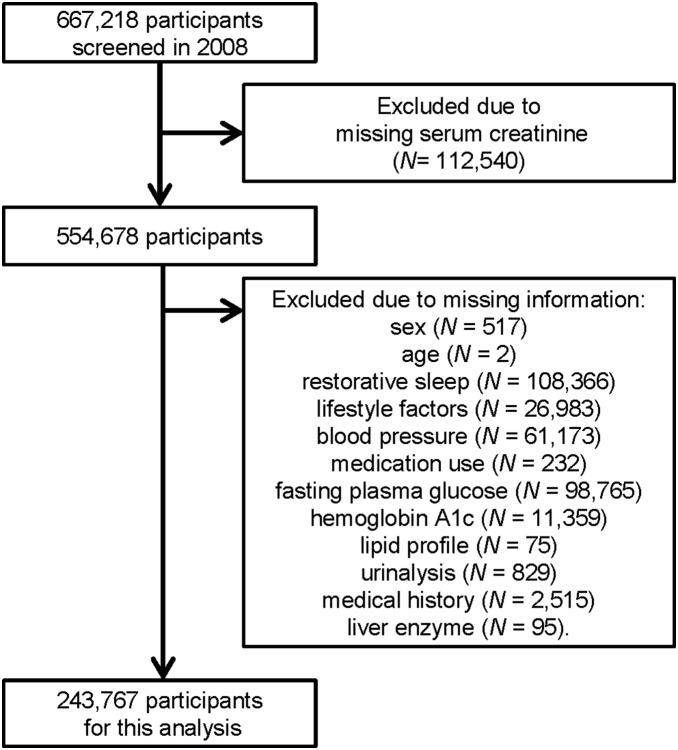
Flow chart of participant selection.Of the 667,218 SHC participants screened in 2008, we excluded anyone with missing information, resulting in a final sample size of 243,767.